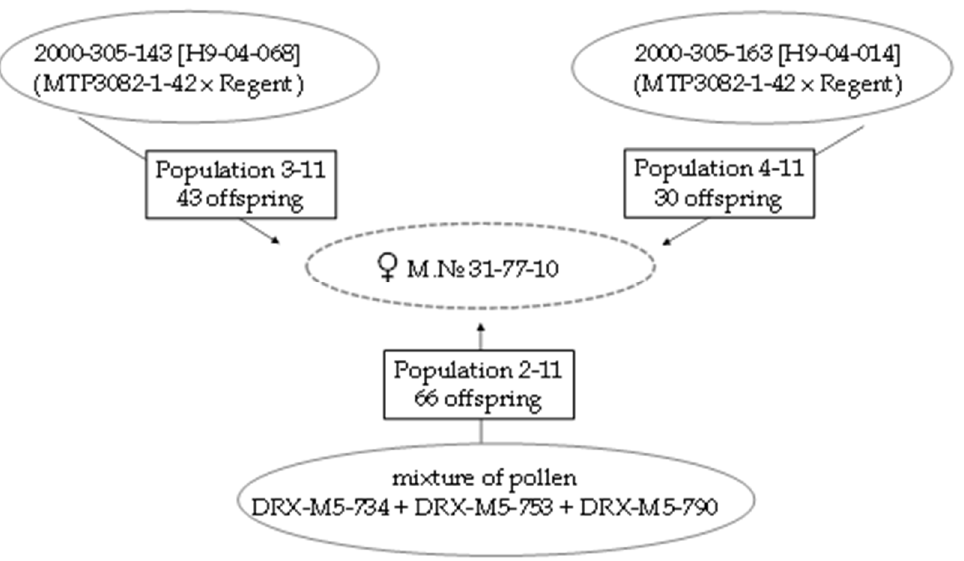
Figure 2. Grapevine hybrid populations (3-11, 4-11, and 2-11) carrying introgressions from M. rotundifolia developed in the Research Institute of Viticulture and Winemaking ‘Magarach’ (Crimea) using male parents 2000-305-143 and 2000-305-163 and pollen of DRX-M5 hybrids (respectively) as donors of resistance loci. In all three crosses, the same female parent, Magarach No. 31-77-10 (M. No. 31-77-10), was